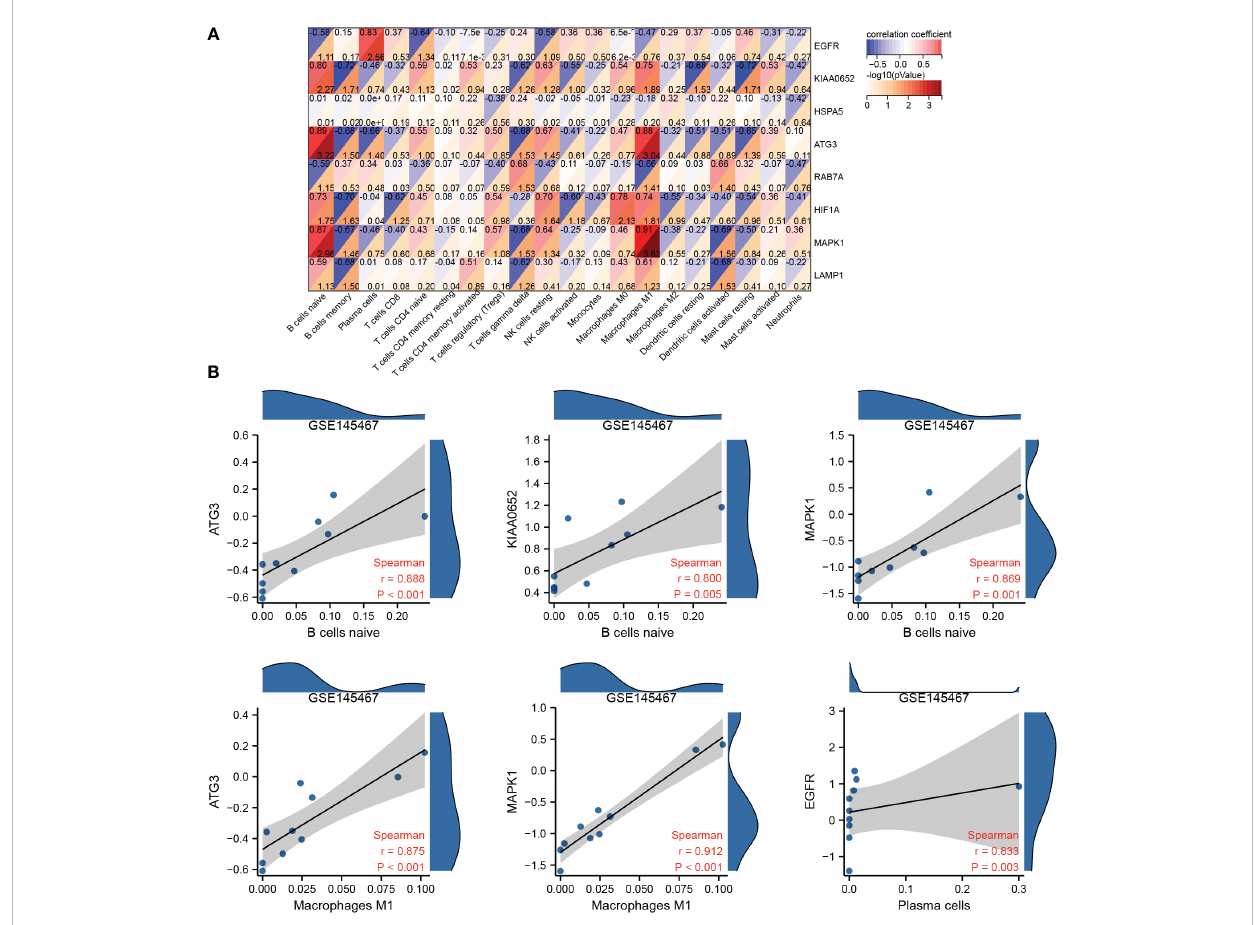
FIGURE 8 Correlation analysis of hub genes and immune cell in fi ltration. (A) : Correlation matrix between hub genes and immune cell in fi ltration in the samples of the impaired spermatogenesis group. (B) : Scatter plot of correlation between hub genes and immune cell in fi ltration in the samples of the impaired spermatogenesis group (only correlation coef fi cients ≥ 0.8 are